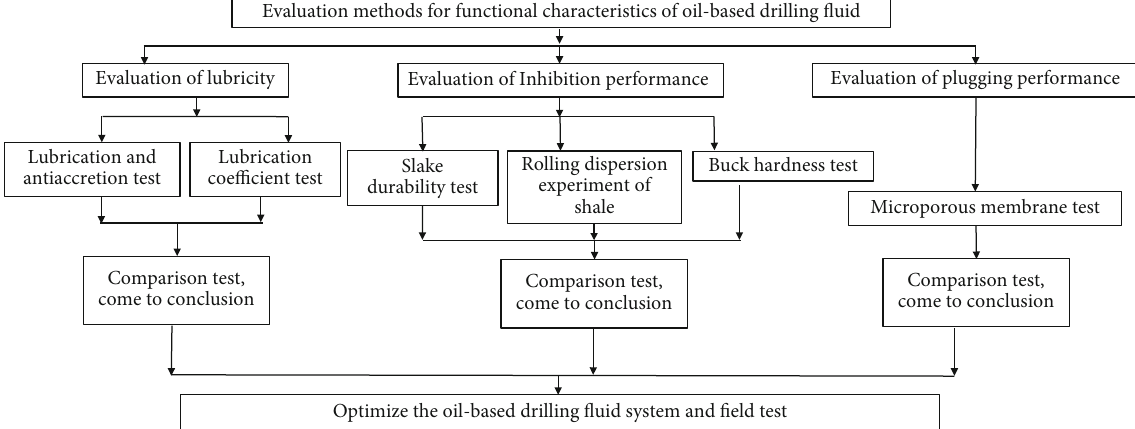
Figure 4: A fl ow chart about the evaluation methods for functional characteristics.